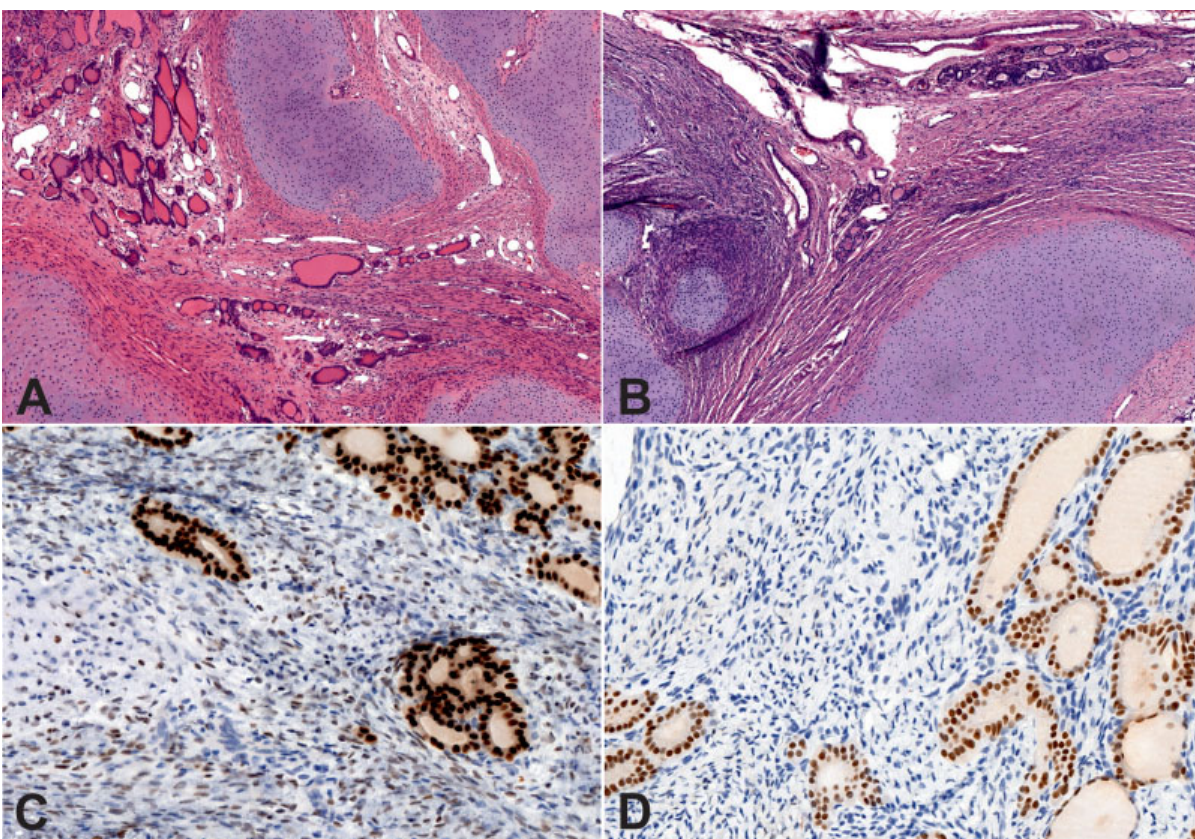
Fig.4 Histology of the specimen. ( A, B ) Large lobules of hyaline cartilage are visible separated by spindle cells and scattered thyroid follicles ( (cid:1) 5 magni fi cation, hematoxylin-eosin staining). ( C ) Thyroid follicles and spindle cells show strong and weak TTF1 staining, respectively ( (cid:1) 20 magni fi cation). ( D ) Only thyroid follicles show PAX8 staining ( (cid:1) 20 magni fi